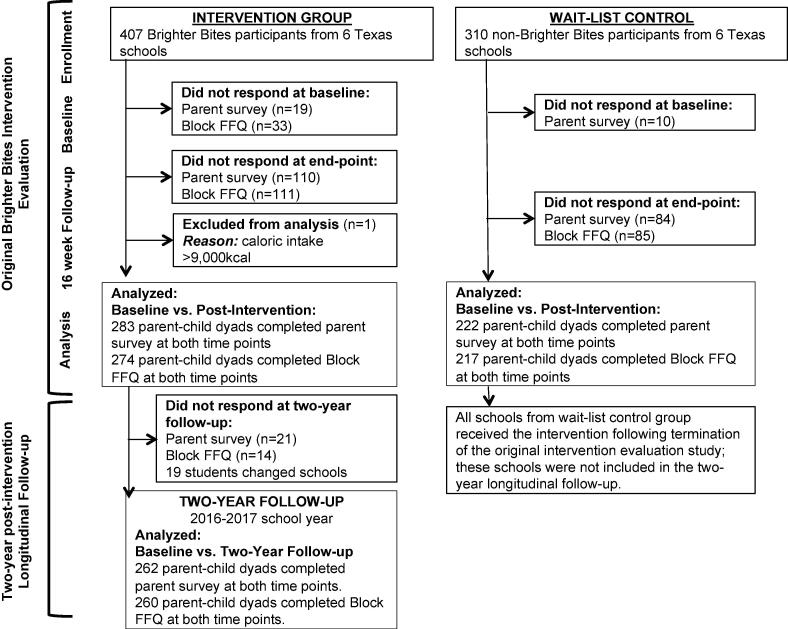
Study Flow of a Two-Year Longitudinal Follow-up Evaluation of Brighter Bites.